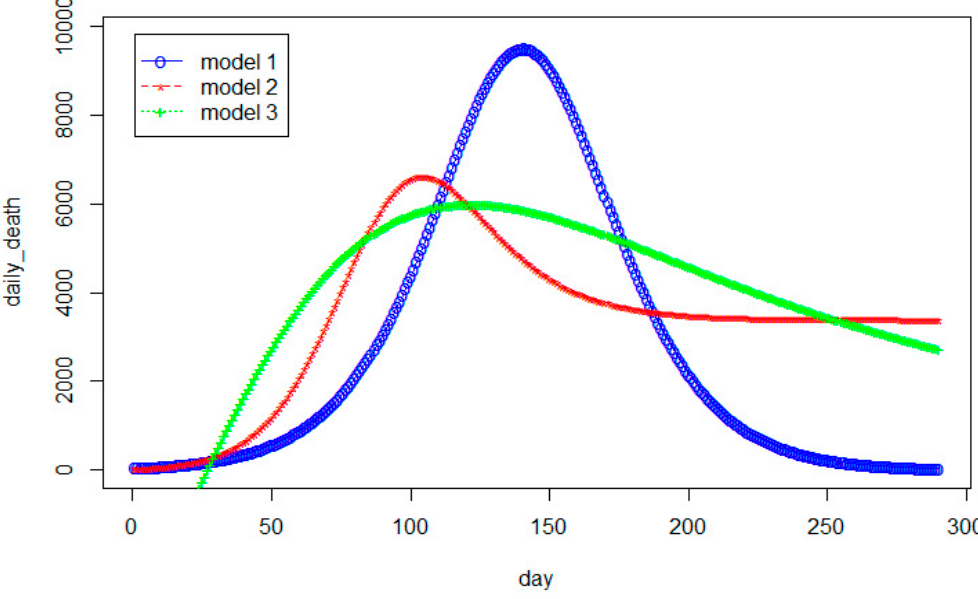
Figure 10. The estimated worldwide daily number of deaths over time.